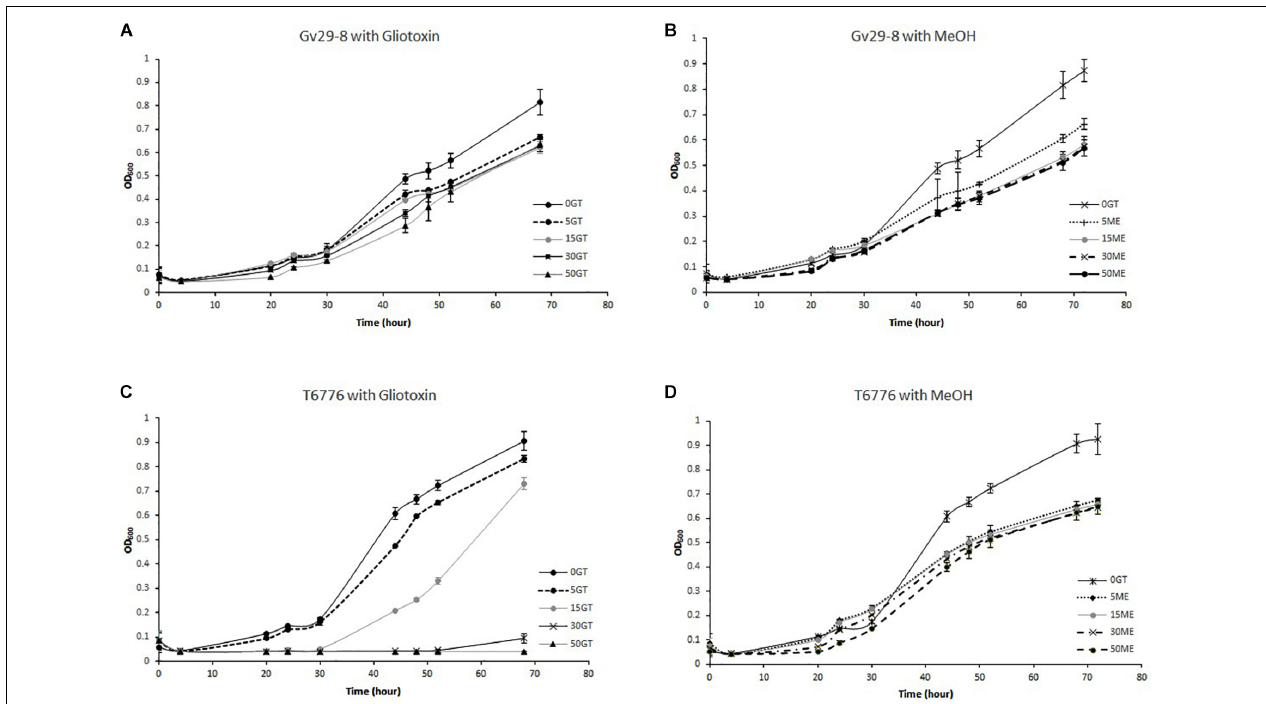
FIGURE 5 | Growth of (A) TvGv29-8 and (C) TaT6776 at different concentrations of exogenous gliotoxin (0–5–15–30–50 µ g/ml). Growth of (B) TvGv29-8 and (D) TaT6776 at different volumes of methanol corresponding to those present in the different gliotoxin (GT) concentrations. Data points represent the average ± standard deviation of biological replicate cultures ( n =